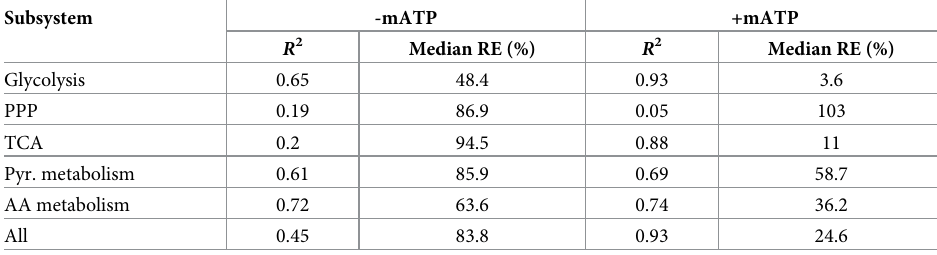
Table 2. R 2 and median relative error (Median RE) of the experimental and predicted fluxes with (+mATP) or without mATP (-mATP) as constraint. Data is shown for biomass equation R_biomass_cho . Subsystem -mATP